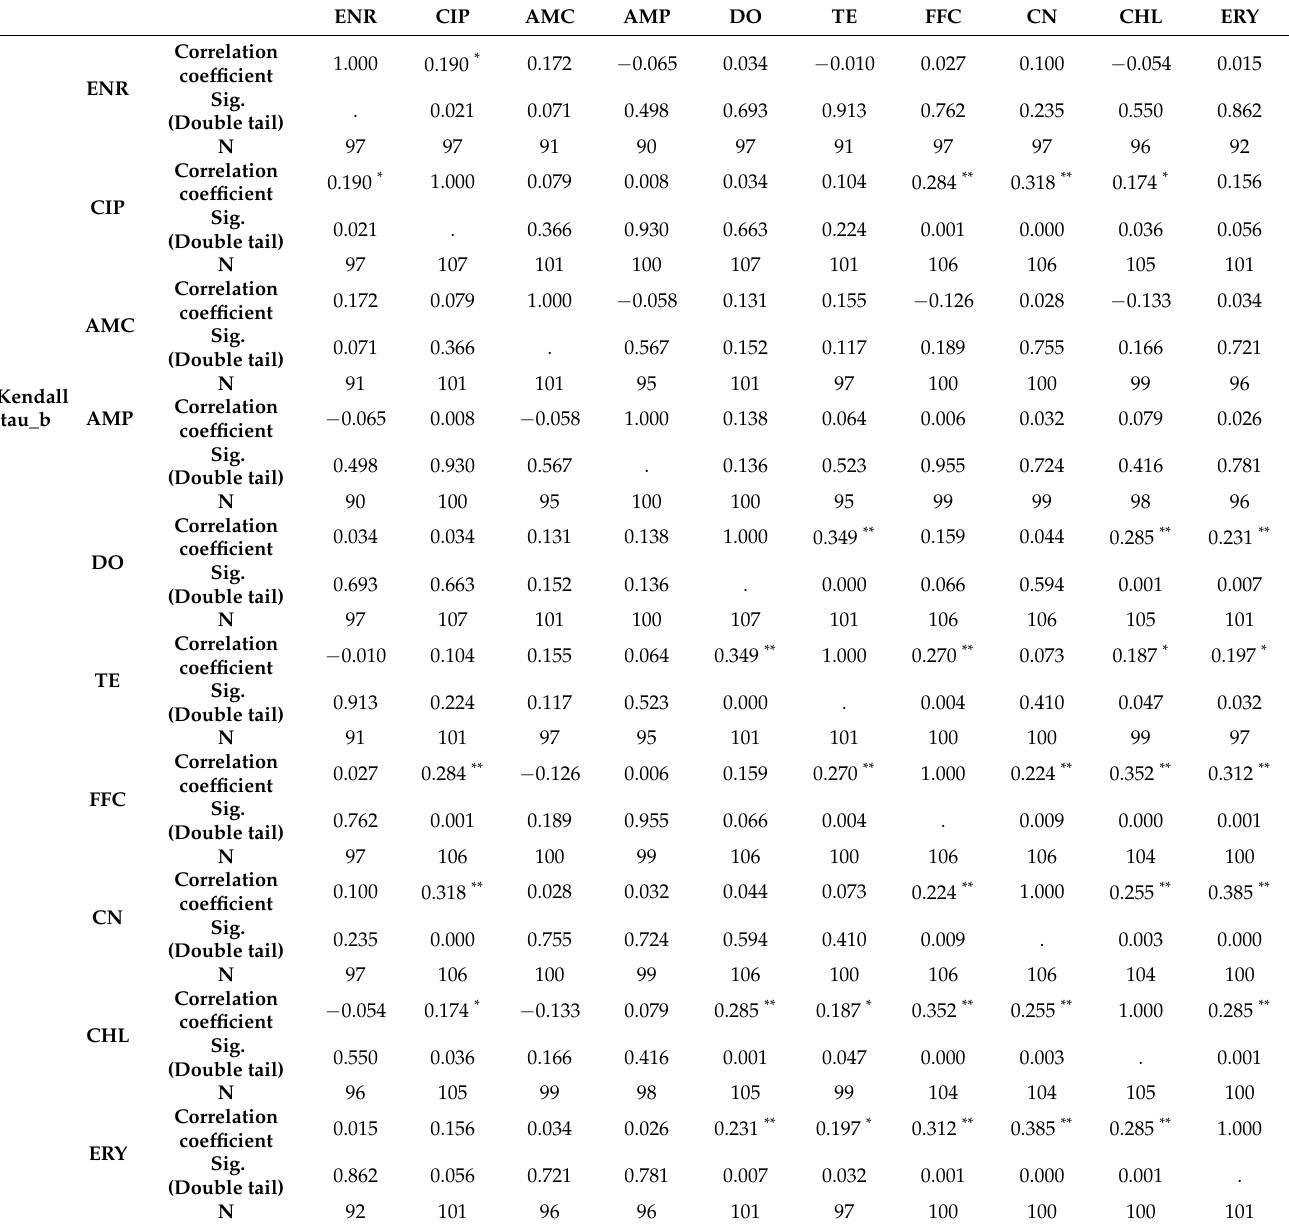
Table 4. Nonparametric correlation analysis of antibiotic